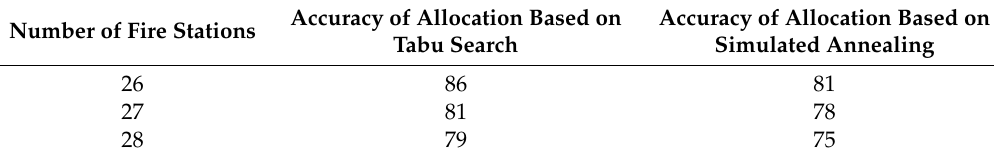
Table 11. Comparison of the accuracy of allocation results.